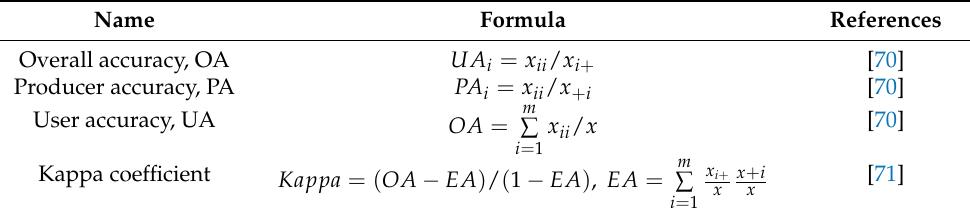
Table 2. Summary of the accuracy measures applied for the prediction models.